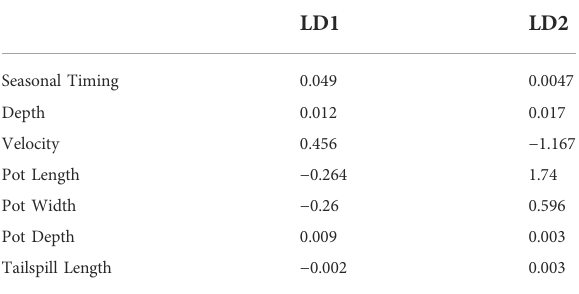
TABLE 2 Coef fi cients from the 2021 DFA model, which show the loading of each covariate on the